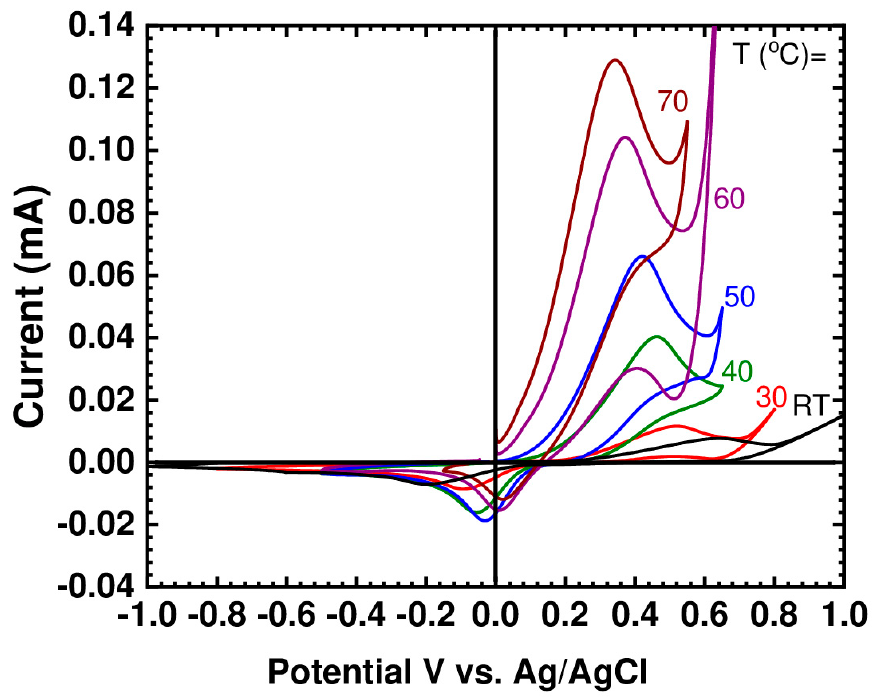
Figure 3. CV of the pure (BMIM)(HQS) at selected temperatures using glassy carbon working electrode, at 10 mV/s scan rate.